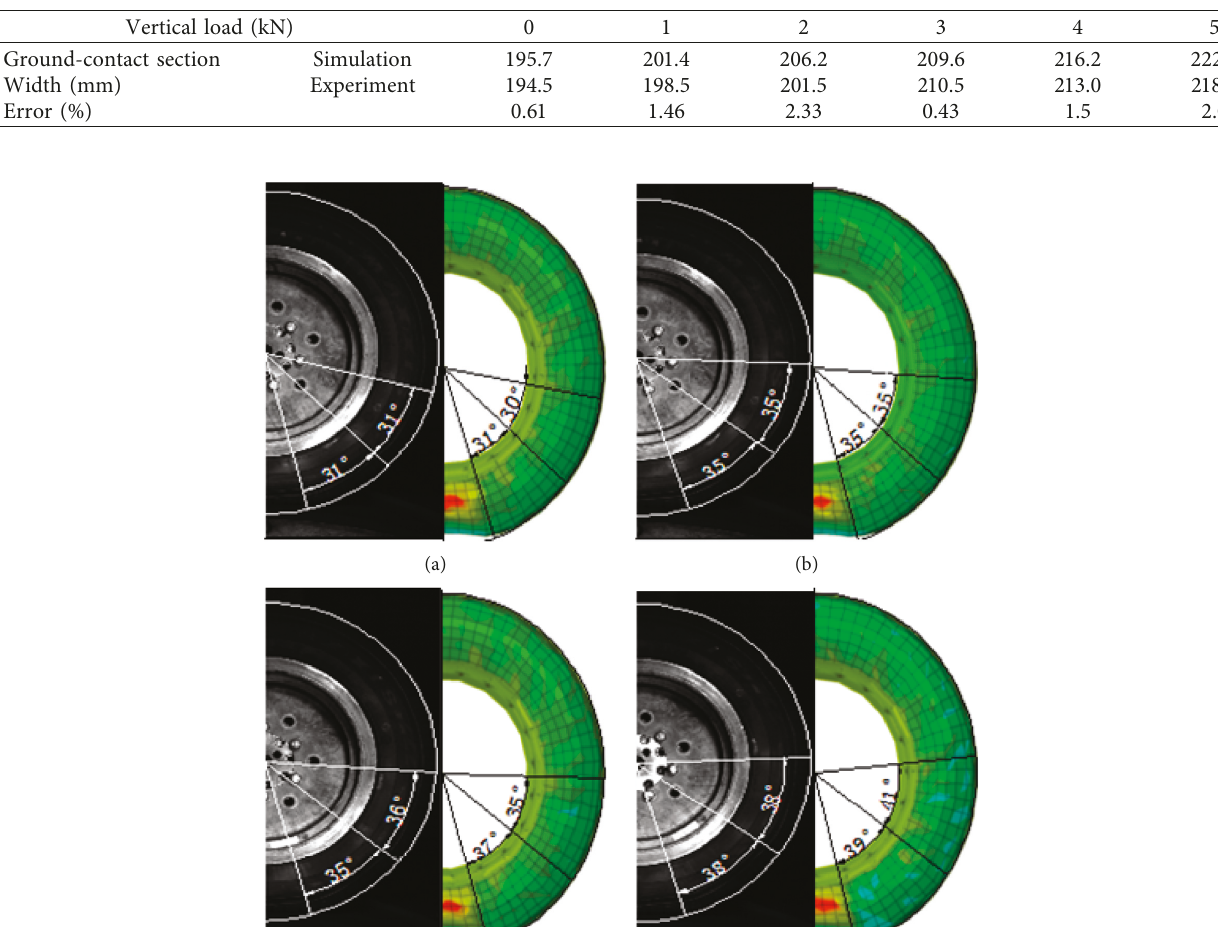
Table 1: Section width by simulation and experiment.